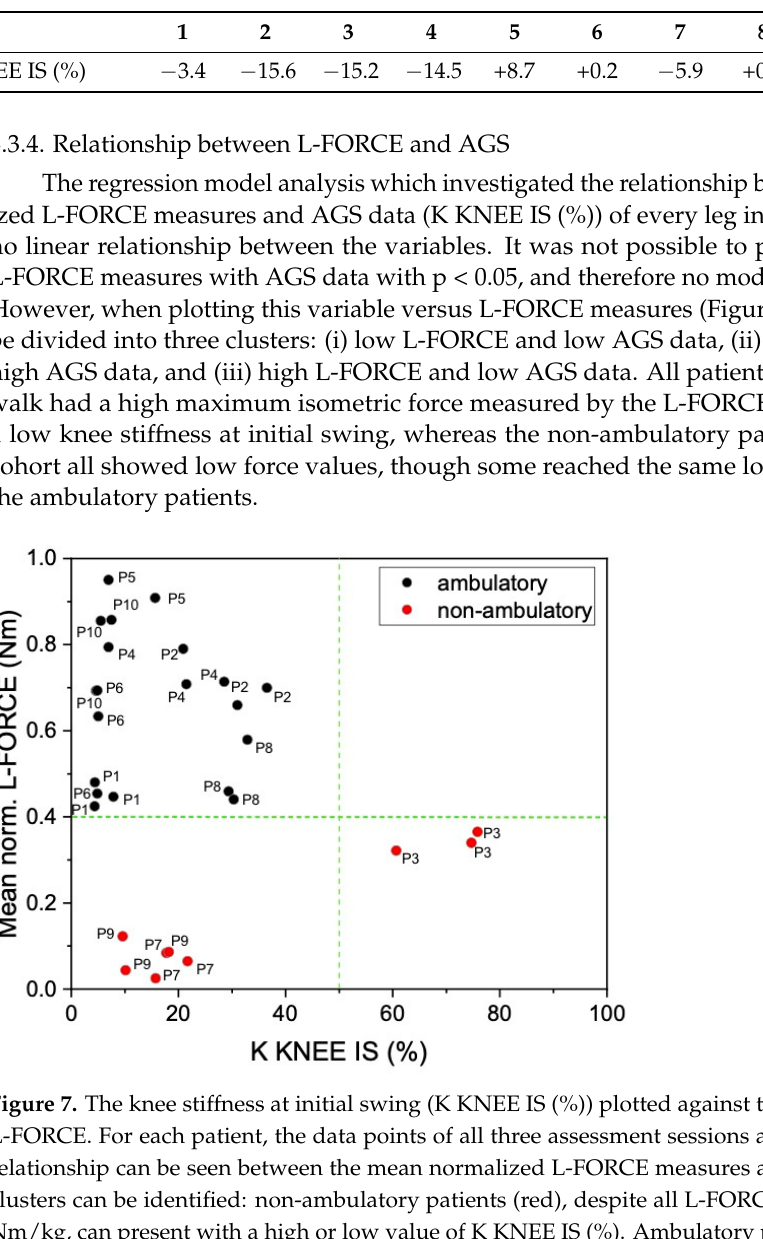
Table 6. Average in percentage change in normalized knee stiffness in the initial swing phase (K KNEE IS) of the left and right leg from the first to last session.